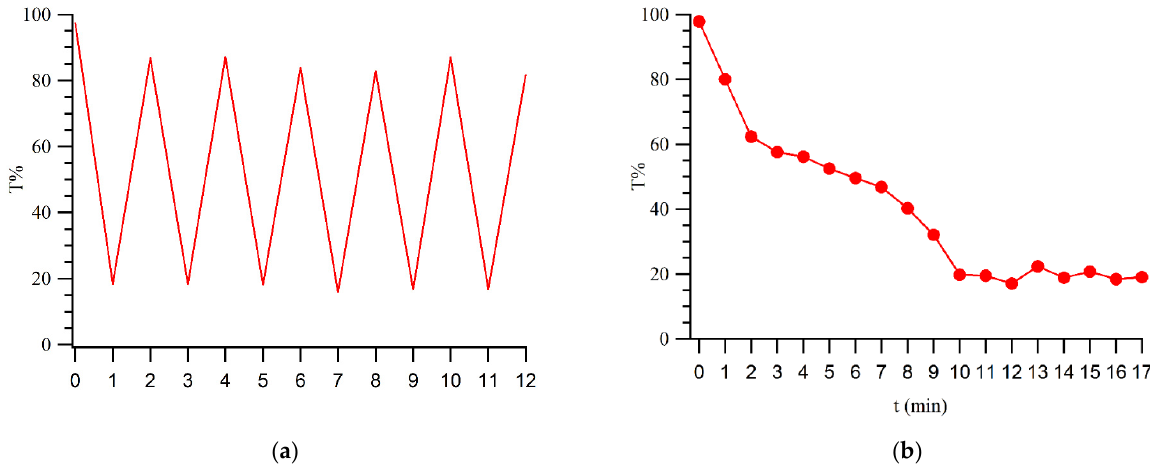
Figure 5. ( a ) UV-Vis transmittance of composite and water mixture at 610 nm with 6 CO 2 /N 2 purge cycles; ( b ) UV-Vis transmittance of composite and water mixture at 610 nm against time.